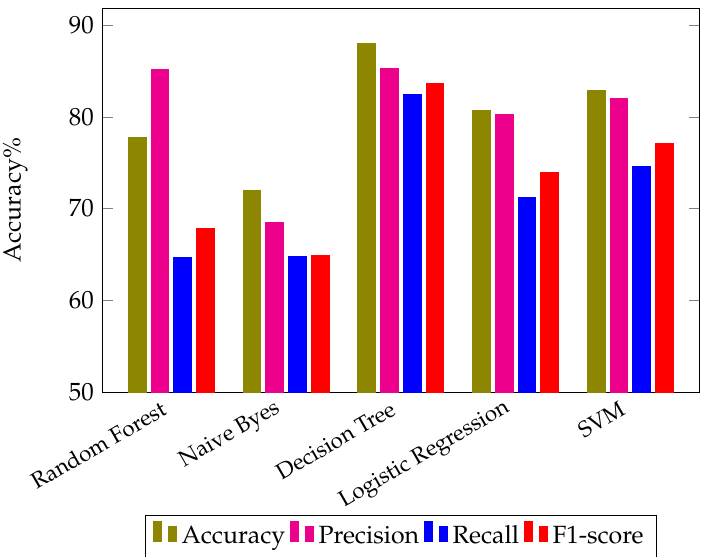
Figure 11. Machine learning Performance on Moderna